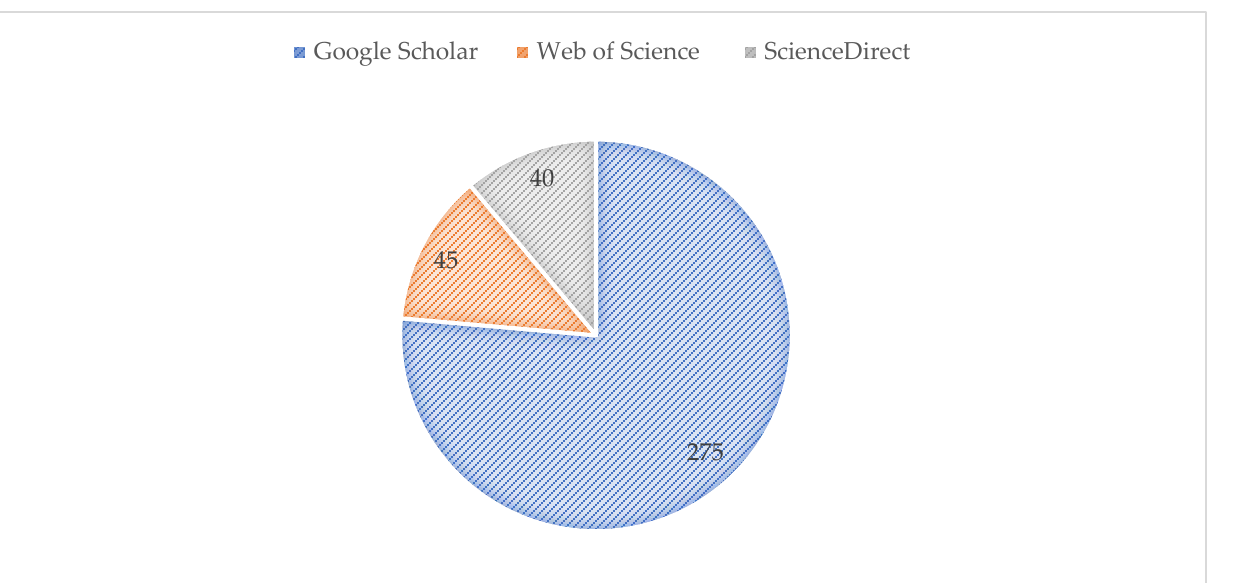
Figure 1. Database of the number of reports from Google Scholar, Scopus, and Web of Science on tannin additives for cryopreservation ( n = 844).